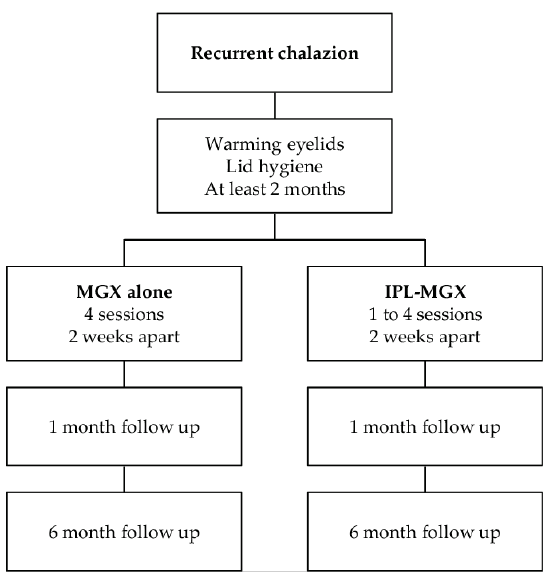
Figure 1. The Clinical Flow of this